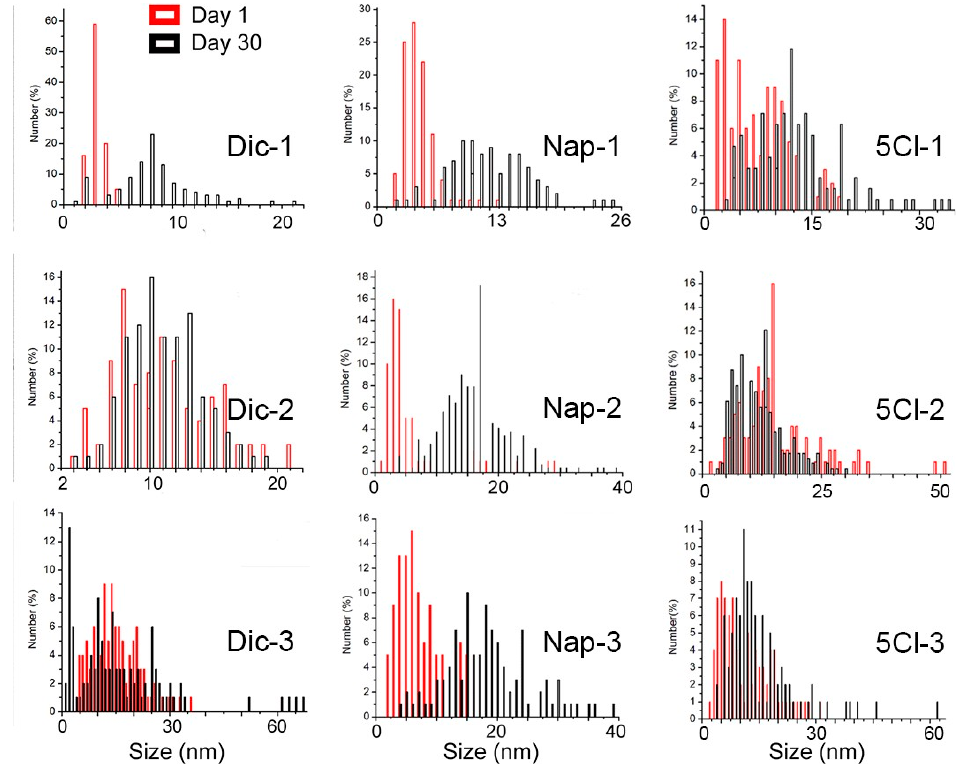
Figure 4. Size distribution of AgNPs calculated from TEM images.